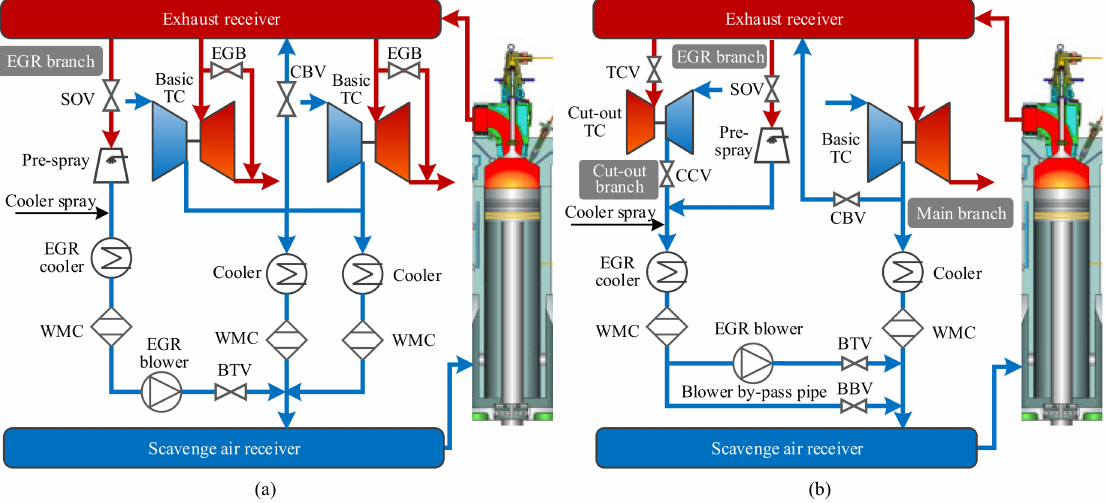
Figure 1. Baseline engine configuration ( a ) and alternative engine configuration ( b ) (CBV, cylinder bypass valve; EGB, exhaust gas bypass valve; WMC, water mist catcher; BTV, blower throttle valve; SOV, EGR shut-off valve; TCV, turbine cut-out valve; CCV, compressor cut-out